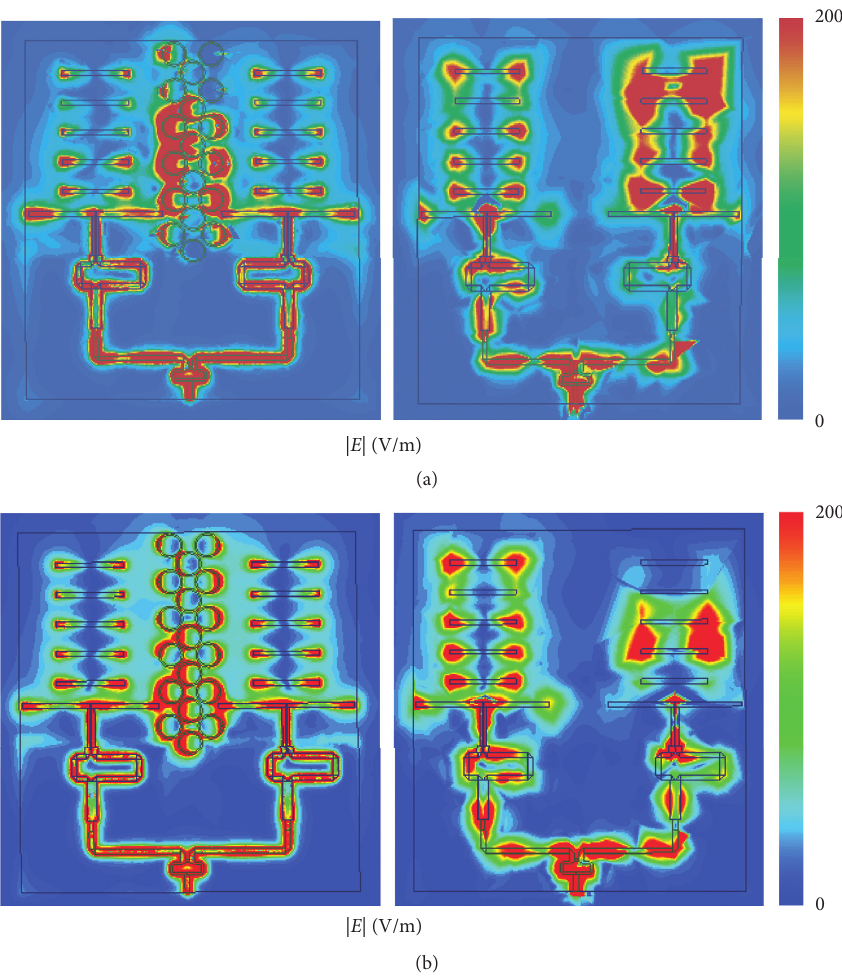
Figure 15: Electric field intensity distribution of the antenna array (0.34 λ Table 1: Comparison of the radiation performance of the proposed antenna array with SRRs and without SRRs. Element spacing 30mm (SRRs/without SRRs) Inverse